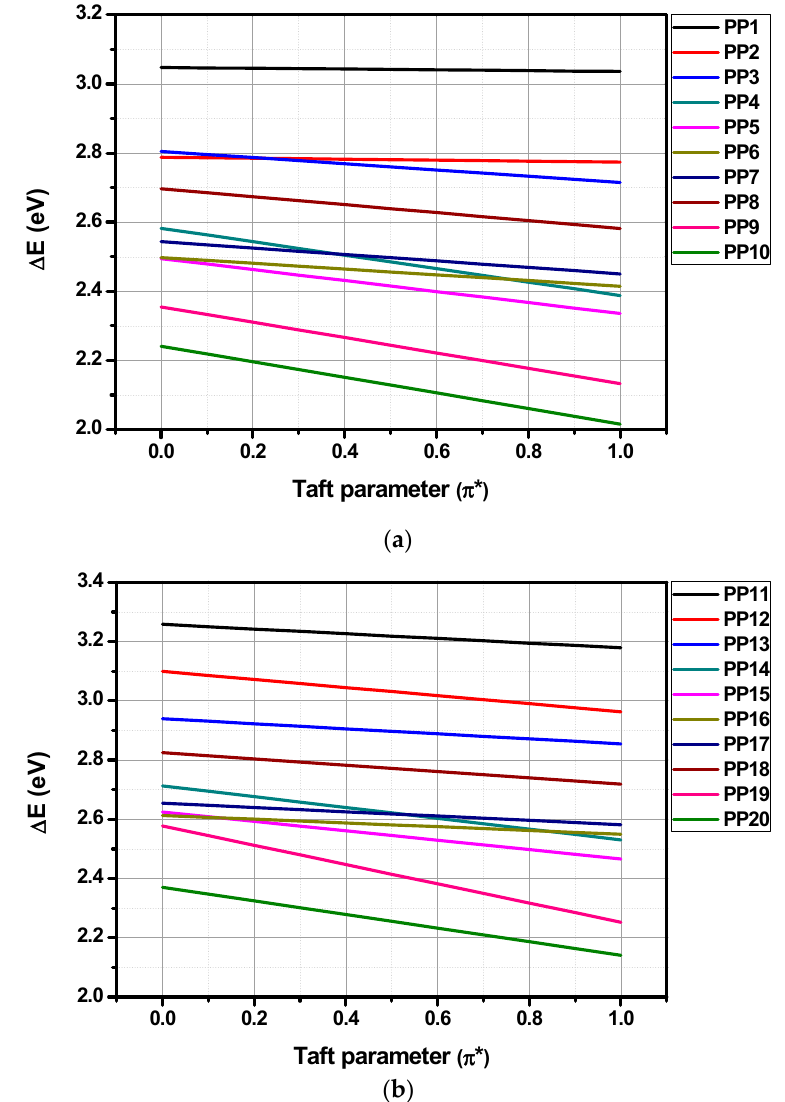
Figure 9. Variation of the positions of the charge transfer band with Kamlet-Taft empirical parameters for PP1 – PP10 ( a ) and PP11 – PP20 ( b ). Table 4. Summary of the optical properties of PP11–PP20 in twenty-three solvents and Kamlet and Taft parameters π *.